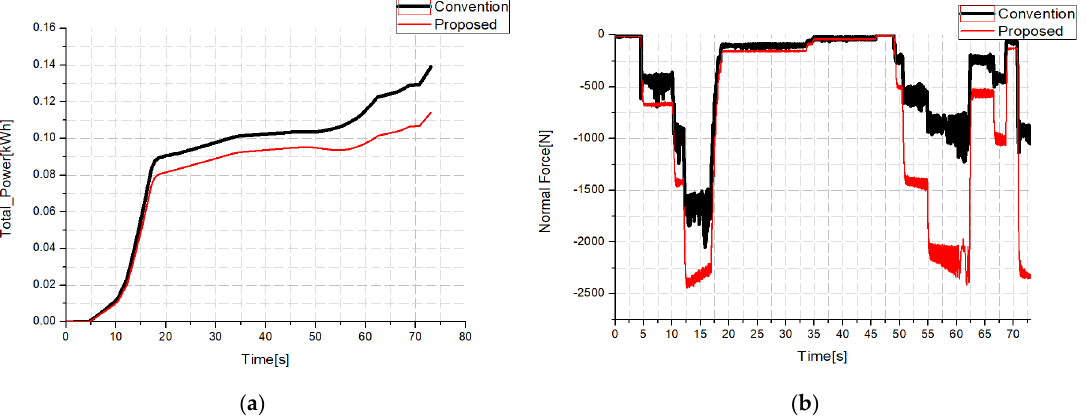
Figure 7. Comparison of existing and proposed condition data: ( a ) Accumulated power consumption and ( b ) Normal train force.